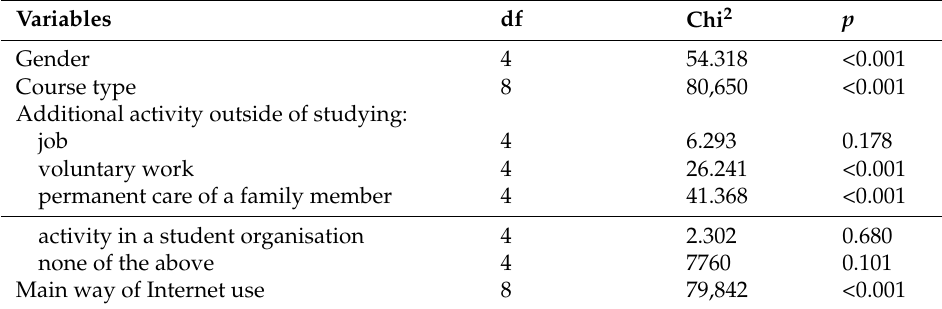
Table 4. Comparison of PIU risk category groups by examined